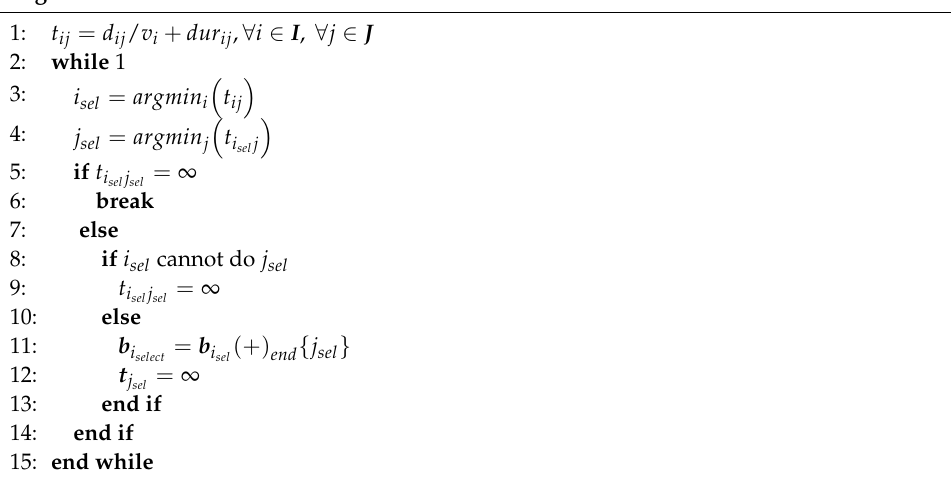
Algorithm 4 Construct initial